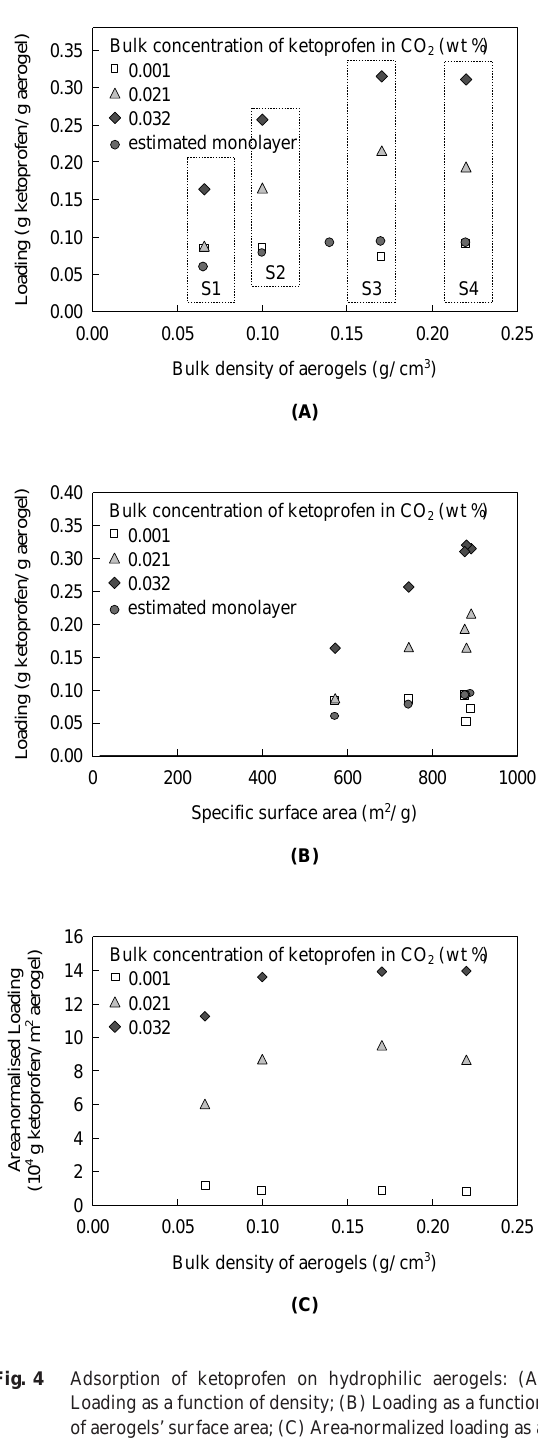
Area-normalised loading of hydrophobic aerogels as a function of